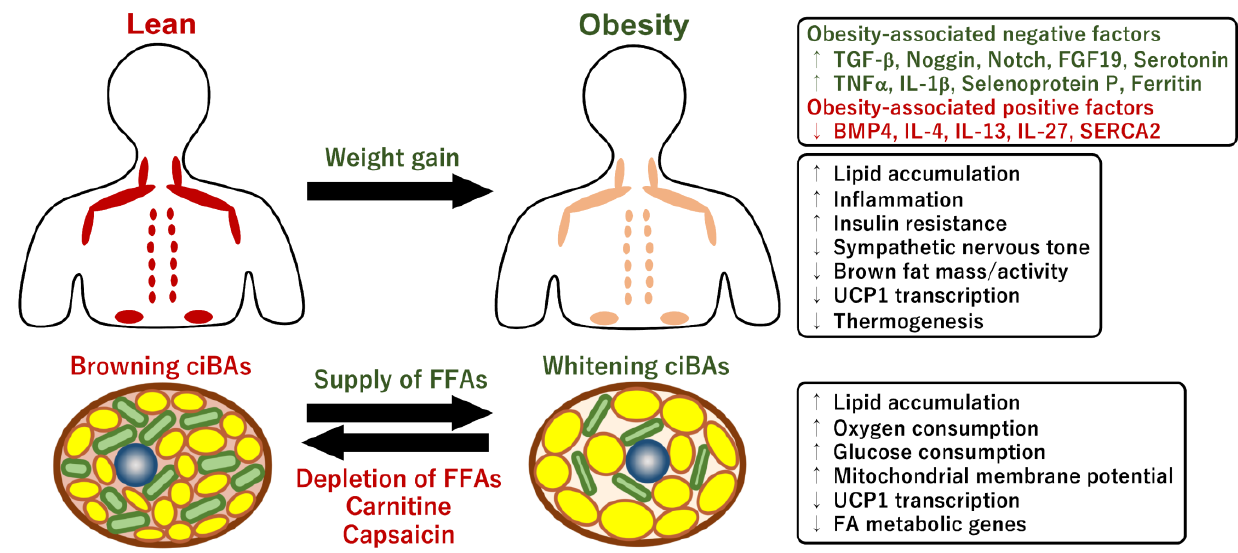
Figure 5. Obesity-associated metabolic differences in human individuals and the brown adipocyte model. Obese human individuals exhibit the repression of BAT mass and activity and lower BAT uptake of blood glucose and free fatty acids compared with those in lean individuals. Mechanisti- cally, the repression is caused by obesity-associated factors that positively and negatively modulate adipocyte browning, de novo brown adipogenesis, UCP1 expression and activity, and adrenergic responses. The amount of the negative factors, such as TGF- β , Noggin, Notch, TNF α , and seleno- protein P, increases under obese conditions, whereas the amount of the positive factors such as BMP4 and Il-27 decreases. The pharmacological modulation of the metabolic pathways involved in these obesity-associated factors may provide therapeutic intervention in the management of obesity and metabolic diseases through brown fats. During the culture of the chemical compound-induced brown/beige adipocytes (ciBAs), the increase in free fatty acids (FFAs) in the culture medium induces white adipocyte-like phenotypes of ciBAs in terms of UCP1 expression and lipid metabolism, which may reflect BAT under obese conditions. In contrast, the depletion of FFAs or prolonged treatment with either carnitine or capsaicin causes the browning process of ciBAs, which may reflect BAT under lean